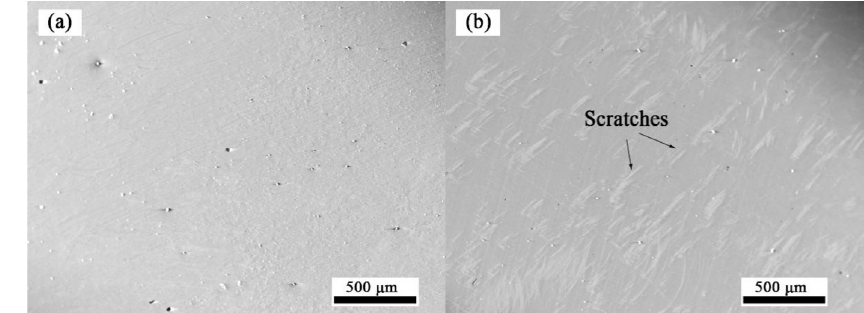
Fig. 7 SEM images at 50× magnification of the femoral head bearing surface: (a) before and (b) after the test.